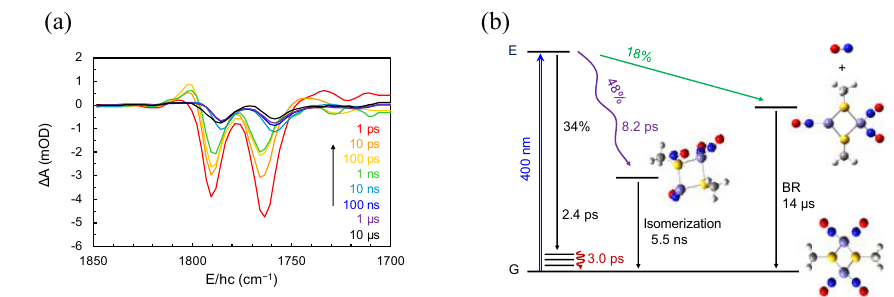
Fig. 1. (a) Representative time-resolved IR spectra of Cys-RRE in D 2 O at 293 K after excitation at 400 nm. (b) A kinetic scheme obtained by fitting the time-resolved spectra globally. The long wavy purple line represents formation process of the isomer B . In the molecular model, CysS was depicted by CH 3 S for the sake of